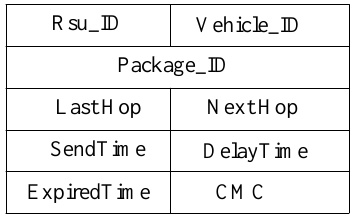
Figure 2. Route reply (RREP) packet.